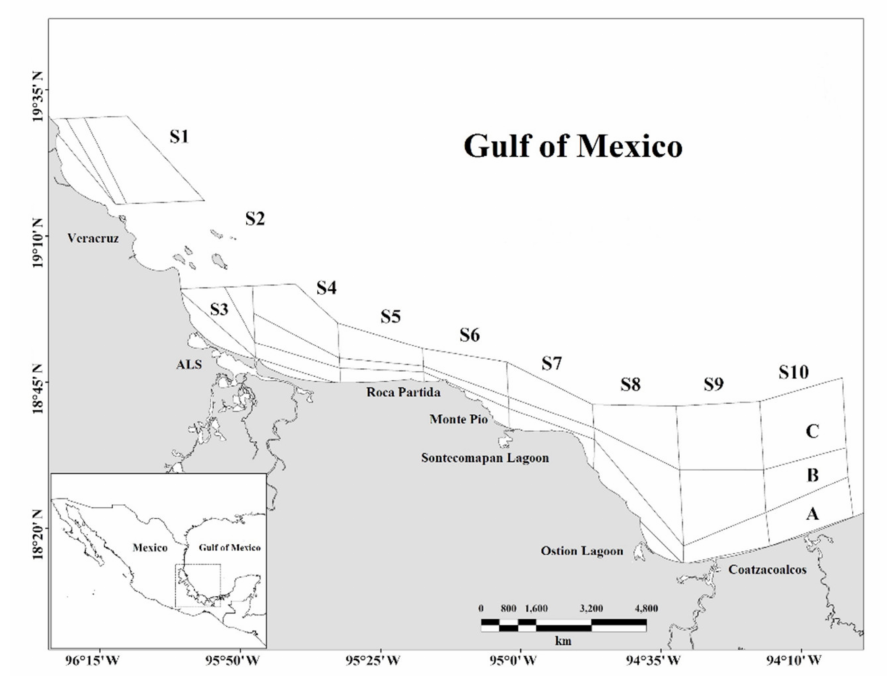
Figure 1. Study area, taken from Mor á n-Silva et al.